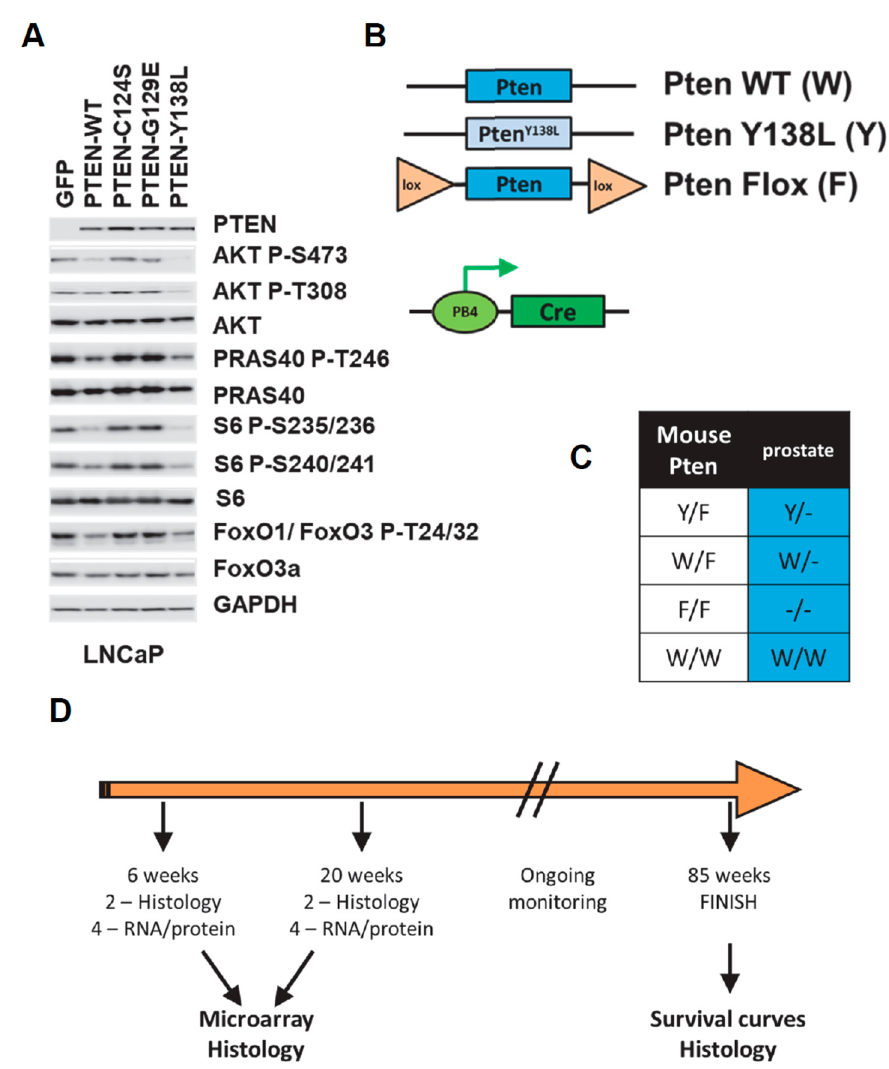
Figure 1. ( A ) Unselected LNCaP cells transiently expressing green fluorescent protein (GFP) or the indicated PTEN proteins were analysed by immunoblotting with the indicated antibodies. Quanti- tation of this data is shown in Supplementary Figure S2. ( B – D ) The study plan uses 2 mutant Pten alleles, a constitutive Pten Y138L allele and a copy of Pten flanked by loxP recombination sites (Flox or F) which can be deleted upon expression of the exogenous Cre recombinase. These are represented alongside the wild-type (WT) gene. The PB4-Cre transgene which expresses Cre specifically in the post-natal prostate-epithelium from a modified probasin promoter is also represented. ( C ) The four experimental genotypes used in the study are represented. F represented the undeleted loxP-flanked Pten gene copy which is fully functional until deleted by Cre specifically during prostate development. ( D ) Groups of mice were sacrificed for tissue at 6 weeks and 20 weeks of age whilst a further cohort were monitored for tumour formation up to the age of 65